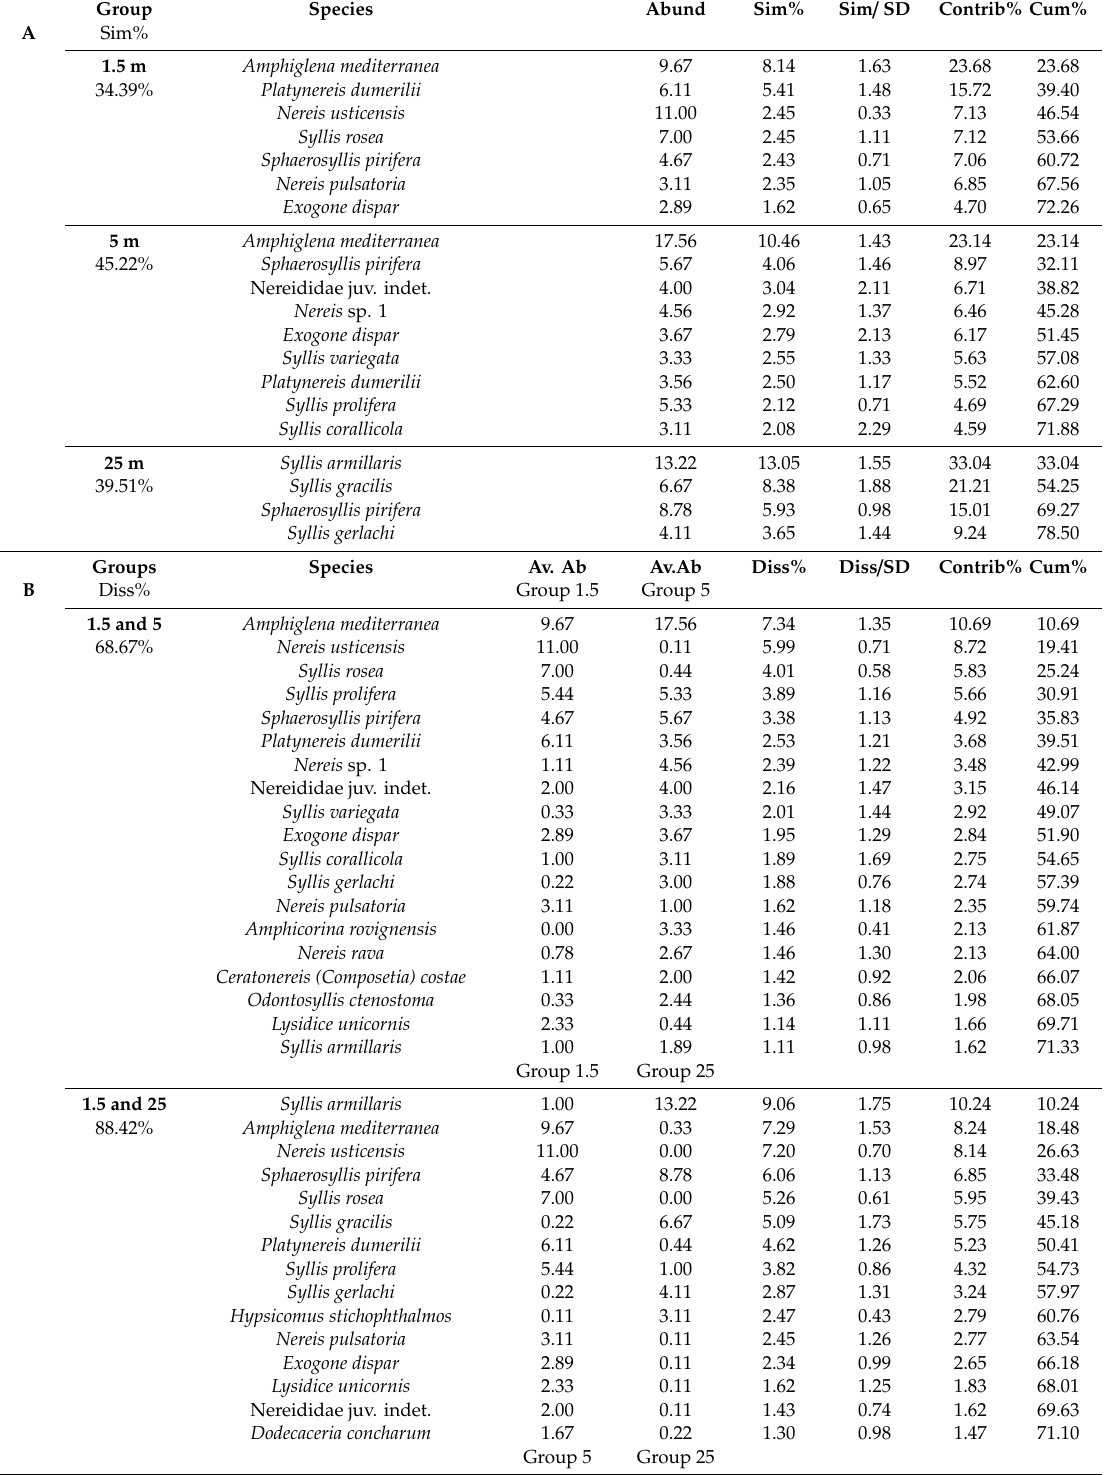
Table 2. Results of SIMPER analyses (cut-o ff 70%) used to identify taxa that mostly contribute to ( A ) faunal similarity within depths, ( B ) faunal dissimilarity between depths. Abund = mean abundance, Sim% = mean similarity, Sim / SD = similarity / standard deviation, Contrib% = contribution relative to single taxon, Cum% = cumulative contribution, Av.Ab = mean abundance, Diss% = mean dissimilarity, Diss / SD = dissimilarity / standard